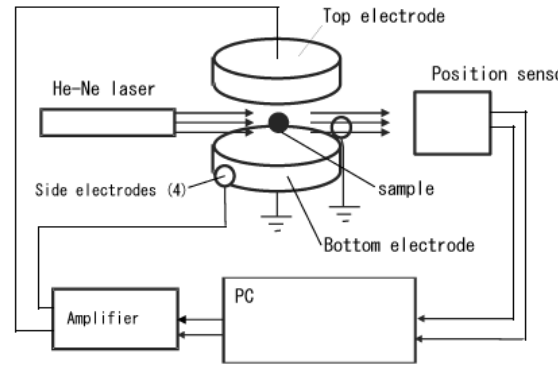
Figure 1. Conceptual drawing of the electrostatic levitation method.